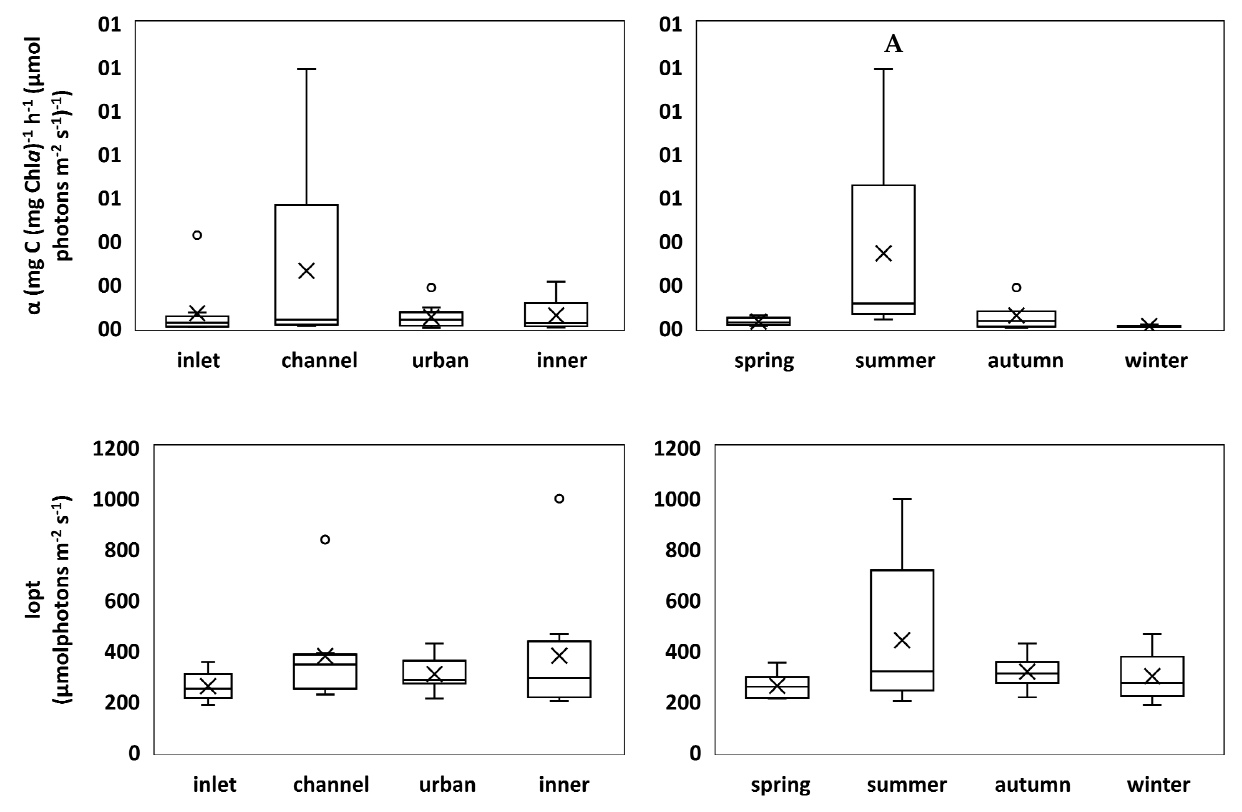
Figure 2. Box − whisker plots showing the median (horizontal line inside the box), mean (cross), interquartile ranges (25th and 75th; boxes), minimum and maximum values (whiskers), and outliers (open circles) for volumetric primary production, aerial primary production, maximal biomass- specific primary production rate (P B max ), photosynthetic efficiency ( α ), and optimal light intensity (I opt ), across sampling locations (left column) and seasons (right column). Significant differences are indicated with letters (A) above the respective bar.